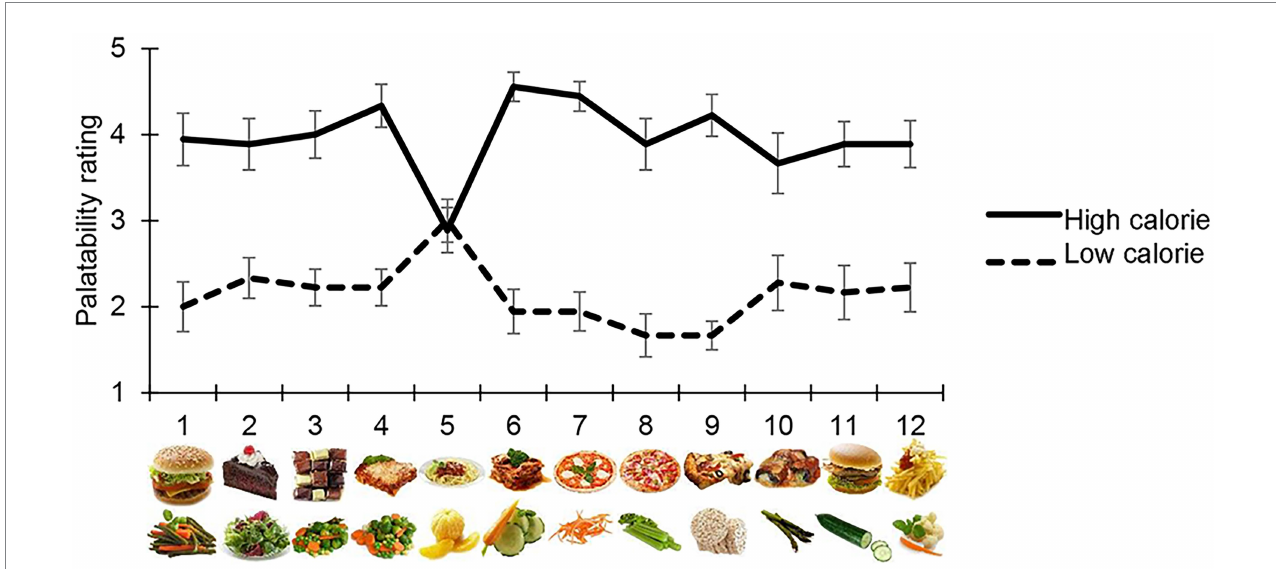
FIGURE 2 Palatability rating. Each participant judged the palatability of each food image used in the main task on a 5-point Likert’s scale. The mean palatability score is shown on the y-axis, for each high/low-calorie stimuli used ( x -axis). With the exception of high-calorie and low calorie item 5, which were excluded from the final analysis, participants considered high-calorie food images as being more appetising than low-calorie